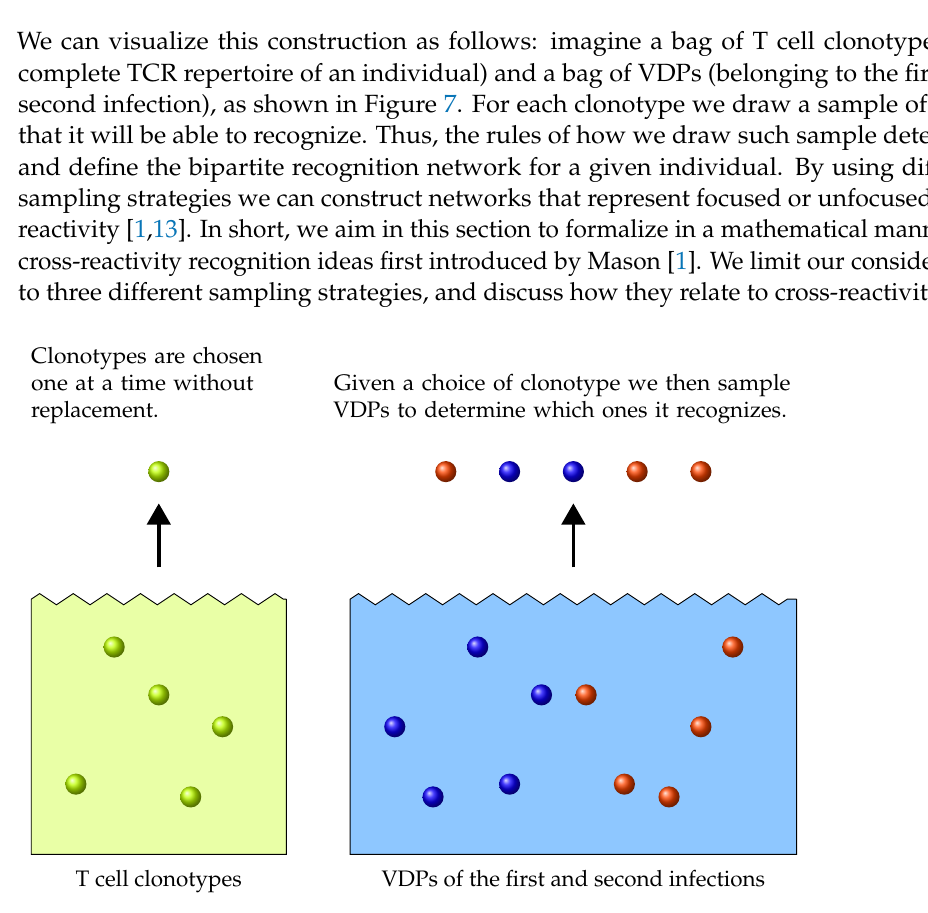
Figure 7. ( Left ) Bag of T cell clonotypes. We chose clonotypes at random from the bag, one at a time and without replacement. ( Right ) A bag of all the available VDPs (from the first and second infection). Once we chose a T cell clonotype, we then sampled VDPs. The sampled VDPs were assigned edges to the chosen clonotype. By considering different sampling strategies from the bag of VDPs, we generated distinct bipartite recognition networks with different properties, such as degree of clustering or cross-reactivity